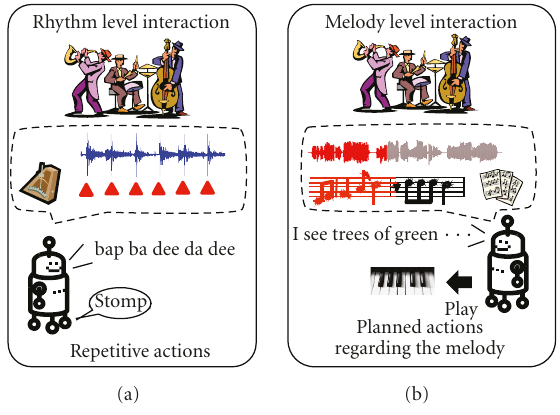
Figure 1: Two levels in musical